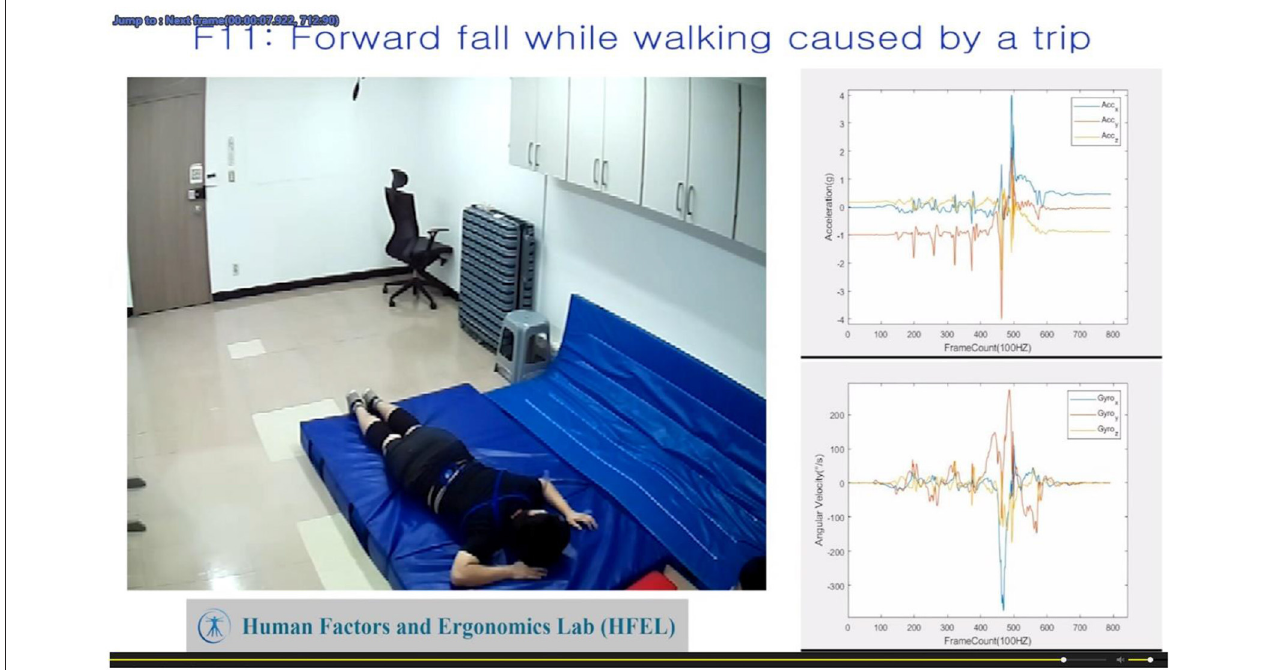
FIGURE 2 | Integrated motion video for the fall time labeling. Left: synchronized fall motion video from the camera; right: sensor data video converted from readings of the inertial sensor (acceleration and angular